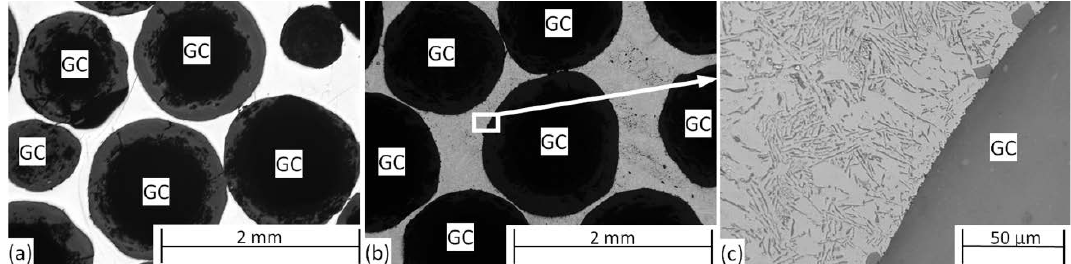
Figure 2. Micrographs of (a) Al99.5- based and (b) AlSi12- based metal matrix syntactic foams (MMSFs); (c) magnified part from subfigure (b) .